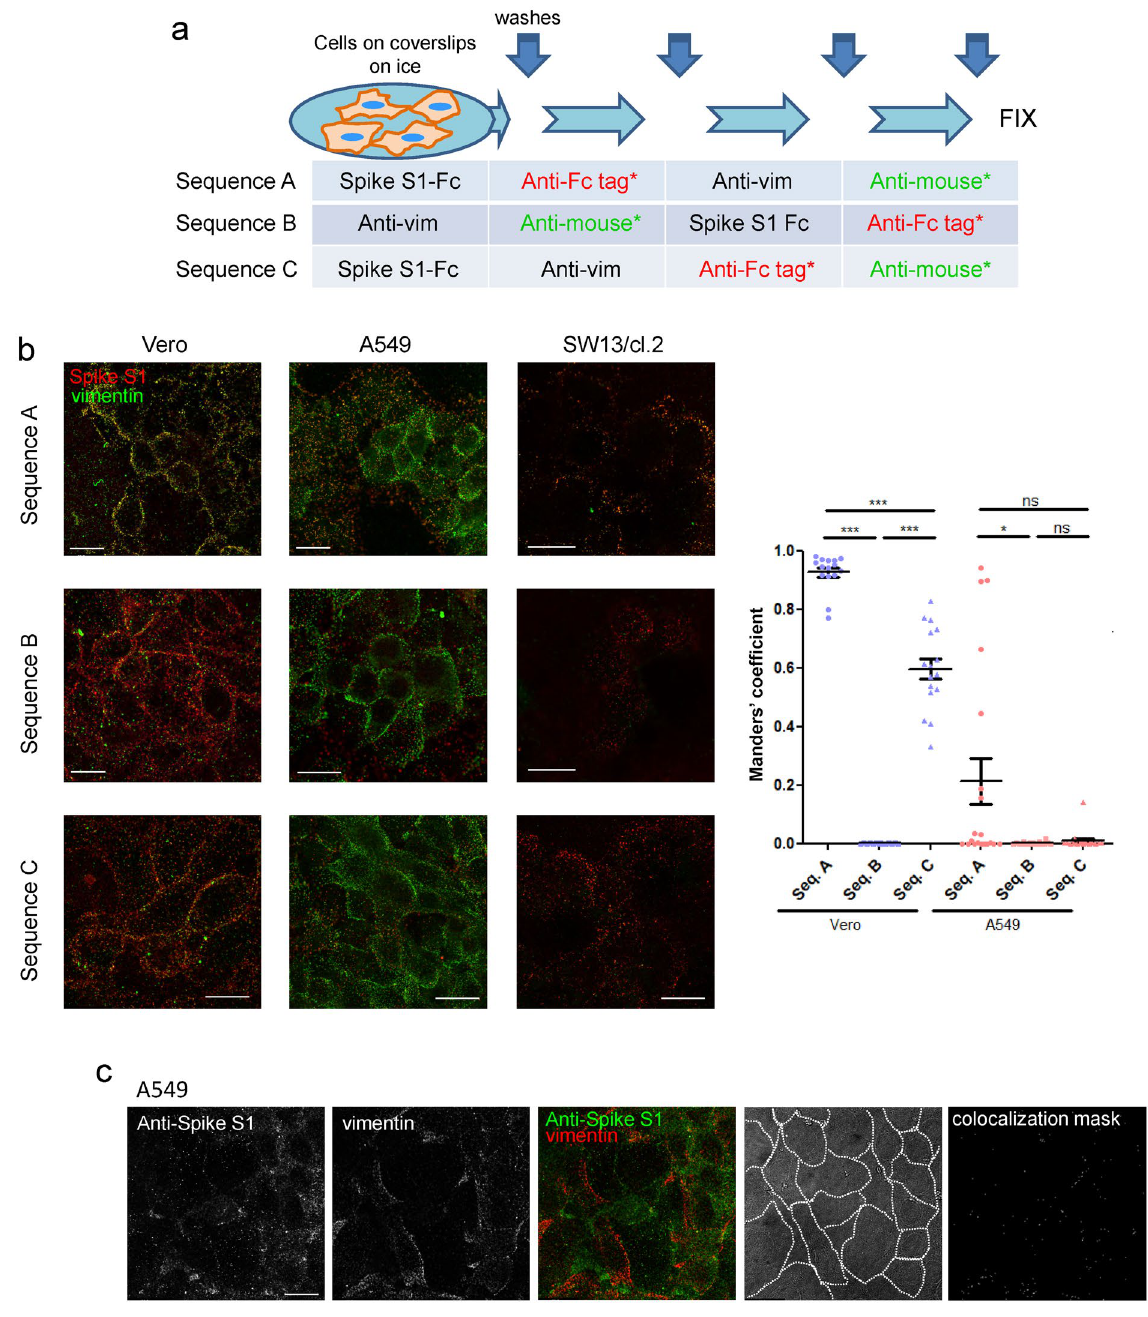
Figure 5. Detection of Spike S1 and vimentin in several cell types employing different immunodetection sequences. ( a ) Scheme of the incubation and washing steps performed for immunodetection. Incubations were carried out for 1 h in the cold. After each incubation coverslips were washed three times with 200 μl of cold PBS. At the end of the procedure, an additional washing step with water was performed before coverslips were allowed to dry and mounted. ( b ) Representative images from the detection of Spike S1-Fc and vimentin in the indicated cell lines following the different immunodetection sequences. The graph shows the colocalization between Spike and vimentin fluorescent signals for Vero and A549 cells with every immunodetection sequence assayed. Colocalization is expressed as the proportion of Spike S1 colocalizing with vimentin signal (Manders’ coefficient), measured applying the automatic Costes’ threshold (n ≥ 12 per condition). Results are shown as mean values ± SEM; ns, non-significant, p > 0.05; *, p ≤ 0.05; **, p ≤ 0.01; ***, p ≤ 0.001 by ANOVA with Tukey’s post-test. ( c ) A549 cells were incubated with Spike S1-Fc, after which, immunodetection was performed by simultaneous incubation with anti-S1 antibody and 84-1 anti-vimentin monoclonal antibody, followed by simultaneous incubation with the two corresponding secondary antibodies prior to fixation. The bright field image with cell contours highlighted and colocalization mask are shown at the right. Bars, 20